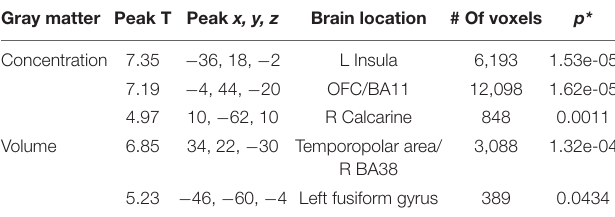
FIGURE 1 | Regional Differences in Gray Matter Results from VBM analysis showing differences between healthy controls and individuals with schizophrenia in terms of gray matter concentration (blue) and gray matter volume (yellow). Results are thresholded at z > | 2| ( p < 0.05, FDR corrected). TABLE 2 | Peak levels and MNI coordinates for significant voxel-based morphometry